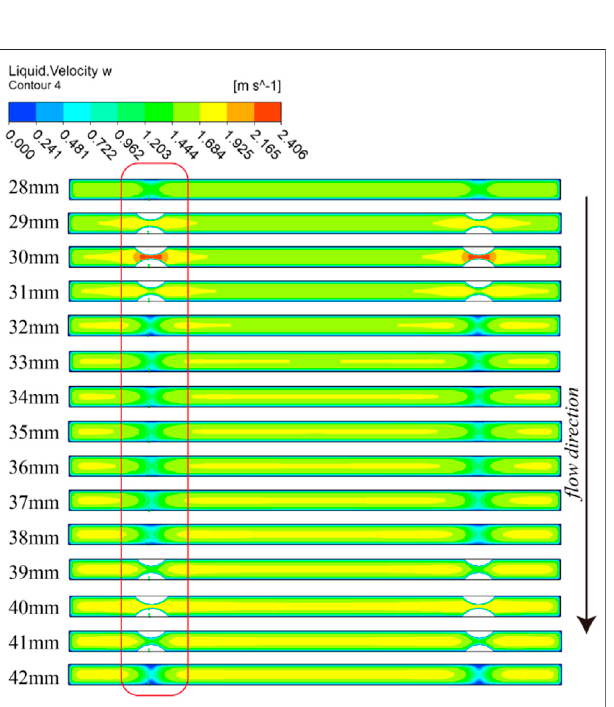
FIGURE 8 | Velocity of liquid phase on different cross-sections channel (number on the left marked positions of cross-sections).